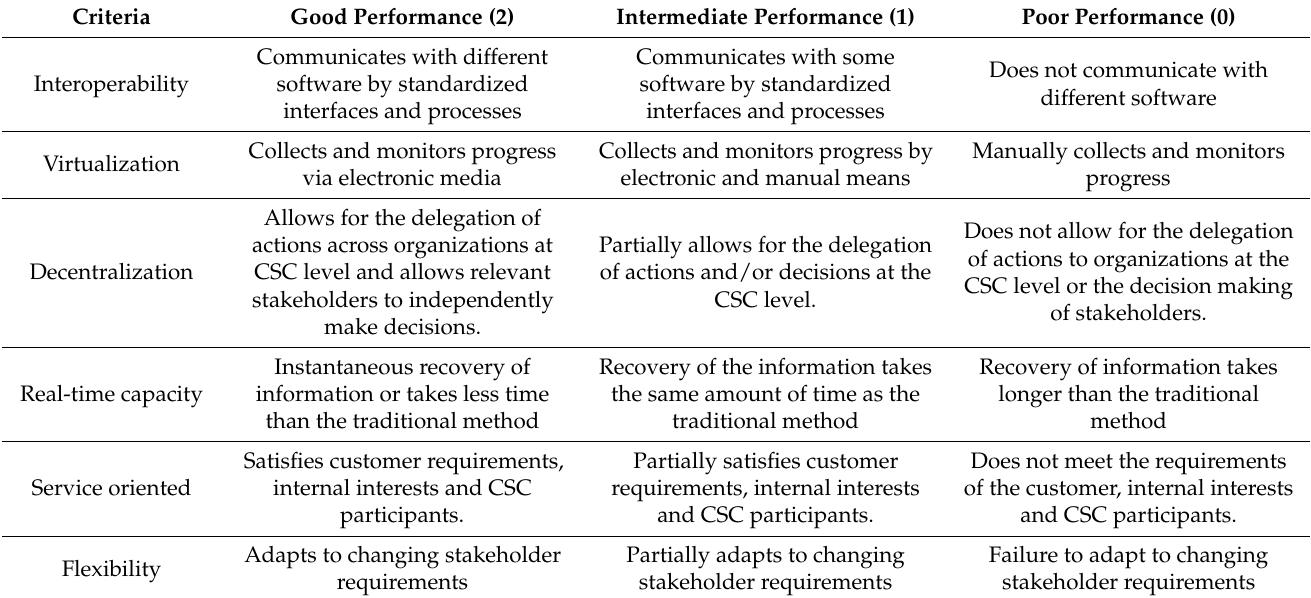
Table 5. Criteria scoring system for CT. Adapted from